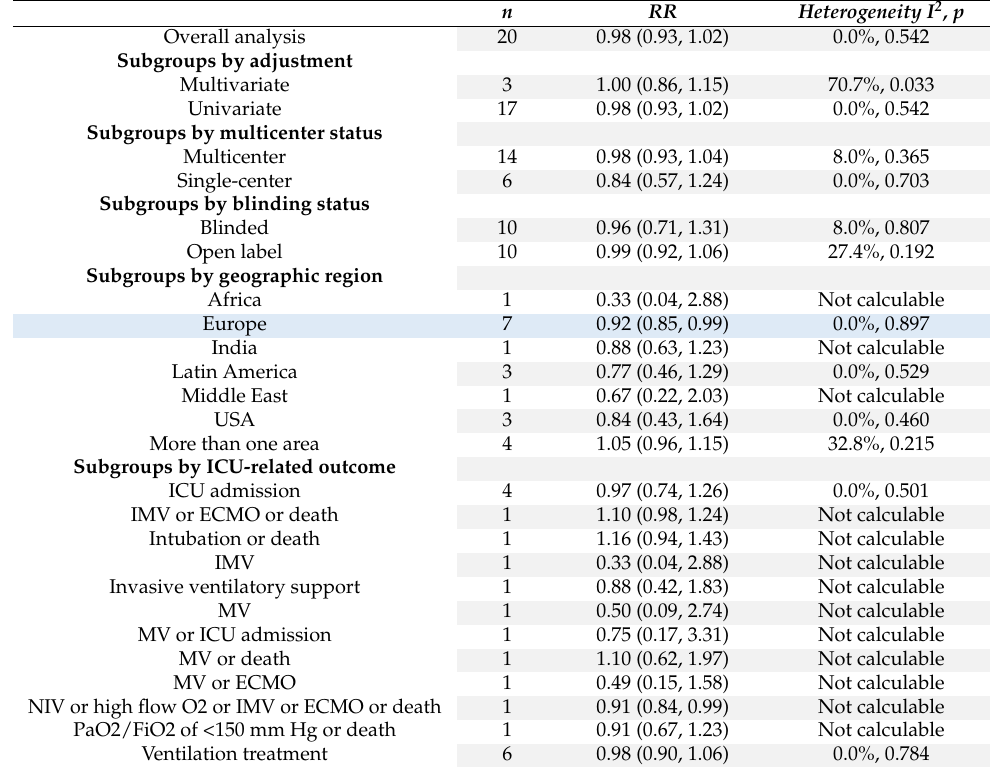
Table 6. Results of the meta-analyses examining the association between convalescent plasma therapy and ICU-related outcomes (28-day); subgroup analyses by adjustment, multicenter status, blinding status and geographic region are